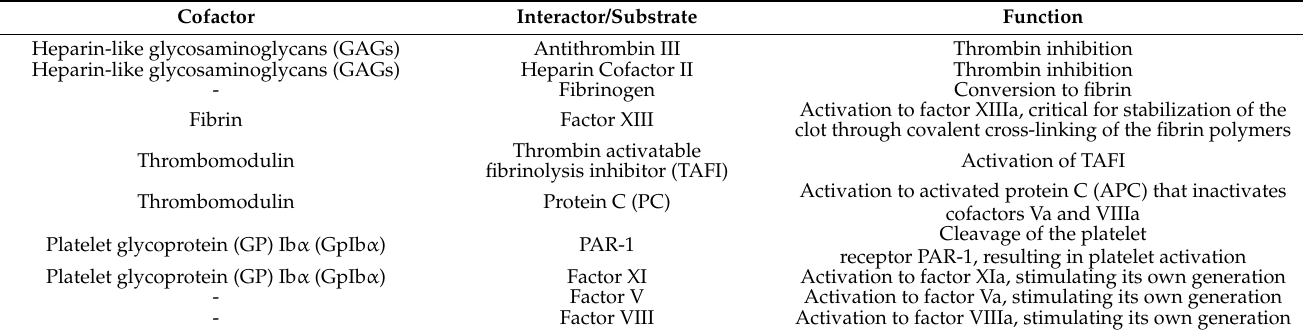
Figure 1. Blood coagulation cascade. The three-dimensional structures of prothrombin (PDB entry 6c2w), thrombin (PDB entry 1ppb), and its substrate (fibrinogen, PDB entry 3ghg) are shown. Thrombin is the key enzyme of the entire hemostatic process and is able to exert both procoagulant and anticoagulant functions [4,5] (Table 1). Table 1. Functional interactors involved in the procoagulant and anticoagulant functions of thrombin.